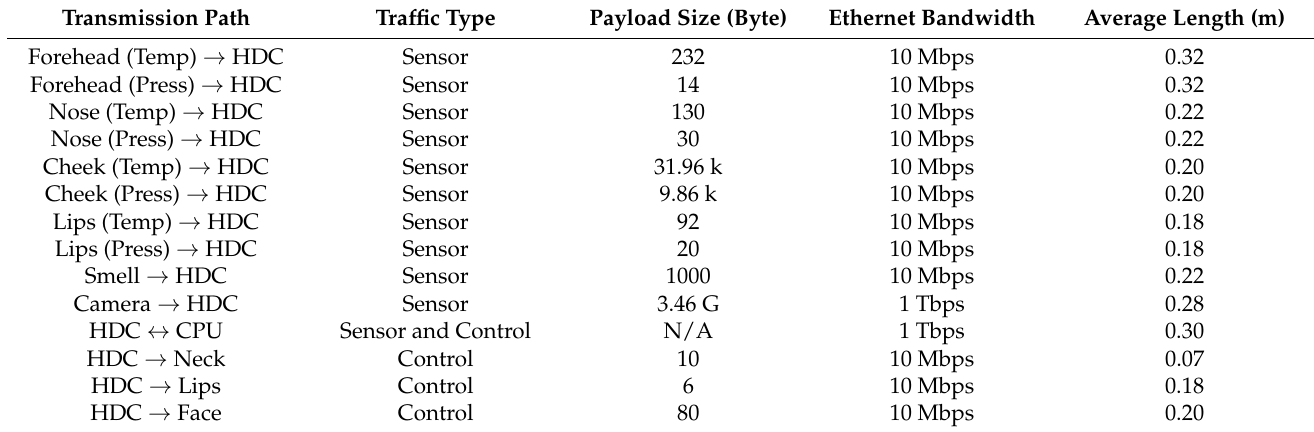
Table 1. Data transmission link parameters of the DIRA Head Domain.